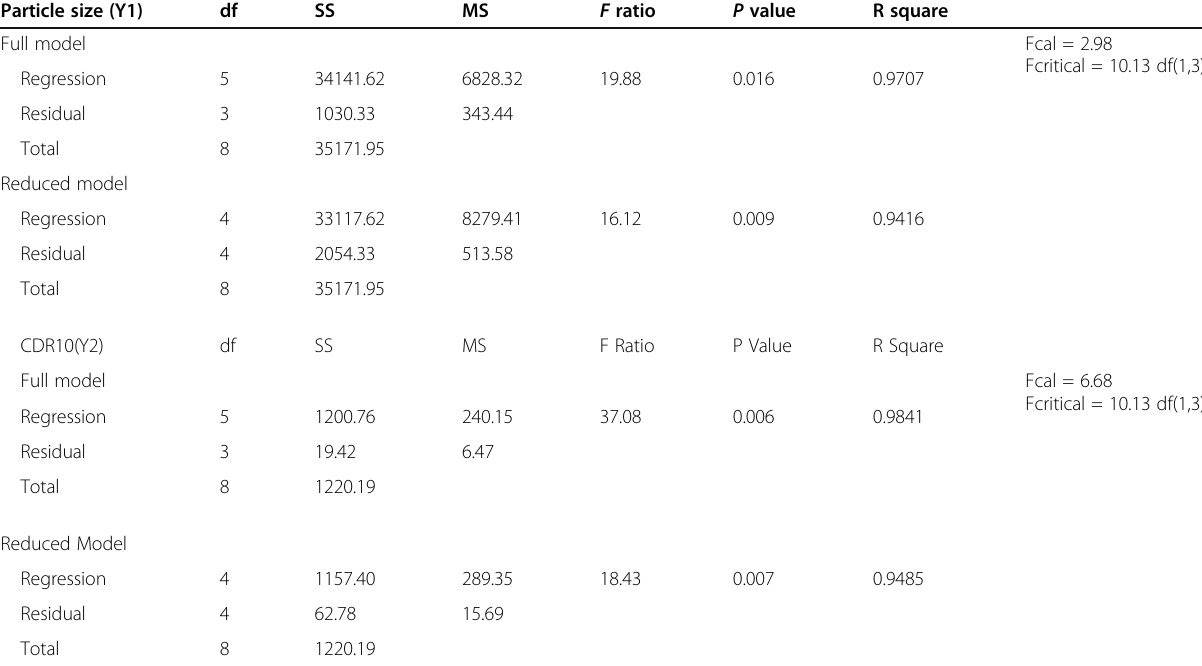
Table 4 Result of analysis of variance Particle size (Y1)